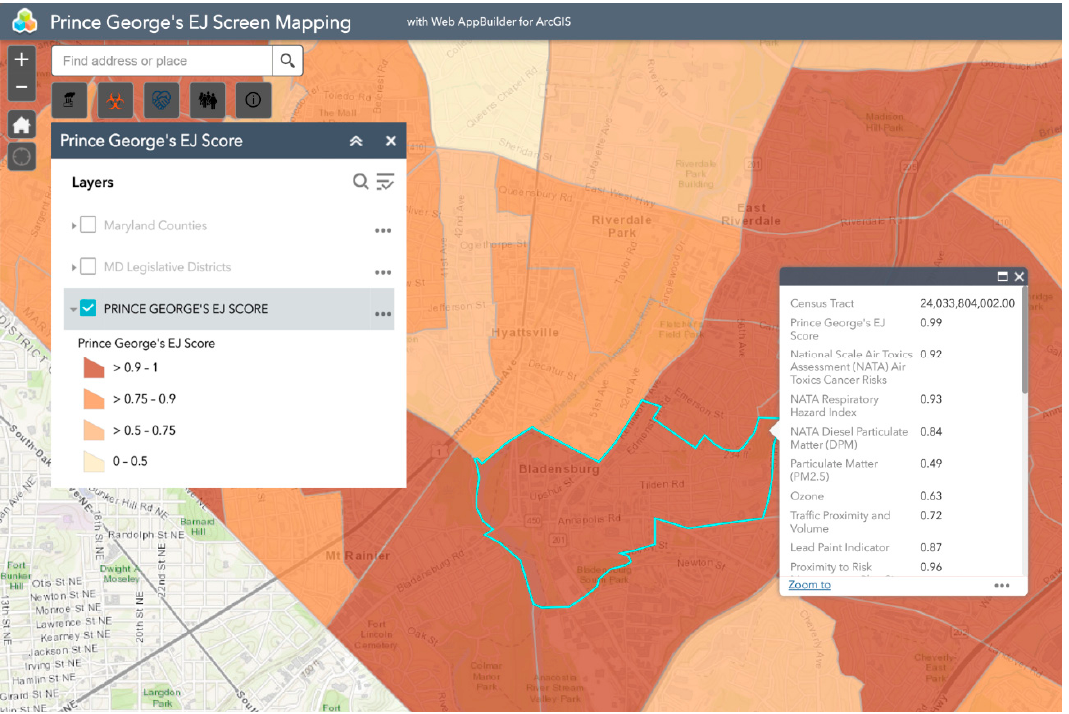
Figure 2. MD EJ Score for Bladensburg. This screenshot from the MD EJSCREEN mapping tool shows the MD EJ Score layer for Bladensburg, MD.